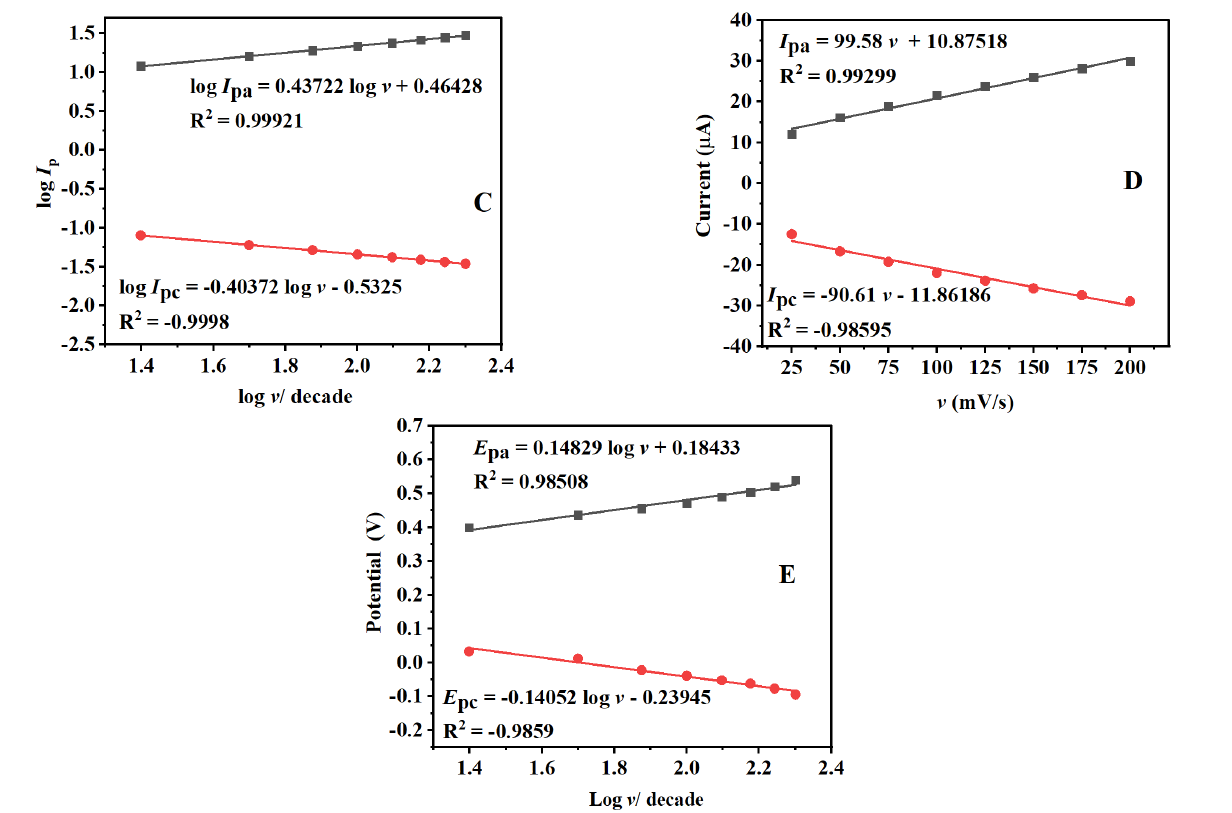
Figure 5. ( A ) CVs in 5 mM [Fe (CN) 6 ] 3−/4− solution at various scan rate (25–200 mV/s) on GCE/TiO 2 - NPs-nafio electrode. Linear plots of ( B ) I p versus v 1/2 , ( C ) log I p versus log v, ( D ) I p versus scan rate versus, and ( E ) E p versus log of v .